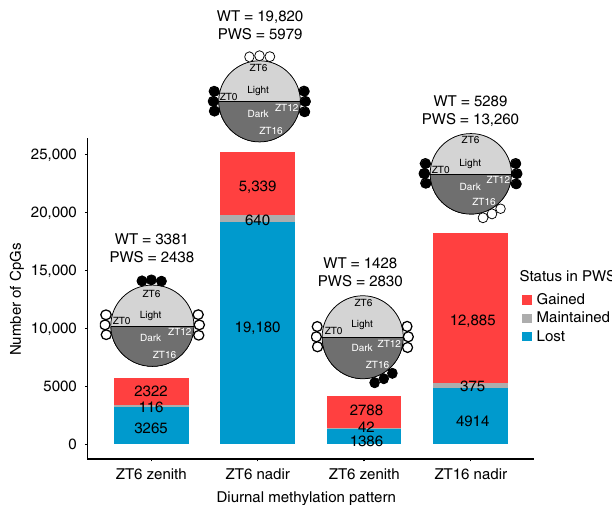
Fig. 3 The majority of rhythmic CpGs in WT cortex reach a nadir at ZT6, are lost in PWS, and are enriched in promoters and enhancers. Number of diurnally cycling CpGs disrupted in PWS. Diagrams above bars graphically represent how methylation nadirs and zeniths were de fi ned in WT, with open circles representing unmethylated and closed circles representing methylated CpG sites speci fi c to a time point. Total number of CpGs belonging to methylation class indicated above ZT0 vs. ZT6 ZT6 vs. ZT12 the two species (3,070 genes, p = 4.7 × 10 − 221 , OR = 2.7). We next utilized data from a recent study which evaluated the diurnal and seasonal rhythmicity of DNA methylation in Alzheimer ’ s disease (AD) and control human cortex to determine if genes with dysregulated methylation in human PWS exhibited diurnal rhythmicity 9 . To de fi ne a diurnally rhythmic gene set from this study, we empirically required 9% of CpGs assayed for each gene to demonstrate diurnal rhythmicity (Supplementary Fig. 4a). Despite differences in methylation analysis platform (WGBS vs. 450k array), 1,834 diurnally methylated human genes overlapped between studies, representing 21.3% of PWS-speci fi c DMR − 96 , OR = 2.1, Fig. 1c and Supple- identi fi ed genes ( p = 1 × 10 mentary Data 3). When PWS DMR genes are fi ltered for rhythmicity, the signi fi cant overlap between mouse and human is maintained, suggesting that rhythmically methylated genes play an essential and conserved role in PWS (250 genes, p = 3.3 × 10 − 13 , OR = 1.7, Supplementary Fig. 4b). These genes Fig. 2 DNA methylation is diurnally rhythmic during light hours in WT, but altered to predominantly dark hours in PWS mouse cortex. a Principal component analysis of WT vs PWS DMRs. Genotype-speci fi c DMRs separate on the basis of time in WT cortex during light hours, but not in PWS cortex. Ellipses represent the 95% con fi dence interval for each group. Non-overlapping ellipses indicate a signi fi cant difference in methylation pro fi le ( p < 0.05). b Rhythmic CpGs during light and dark hours in WT and PWS cortex. Venn diagram overlaps represent the number of rhythmic CpGs. Top = light hours (ZT0 – ZT12), Bottom = dark hours (ZT12 – ZT0). 23,201 WT light rhythmic CpGs > 8,417 Snord116 + / − light rhythmic CpGs (Fisher ’ s exact test, p < 0.0001) and 16,090 Snord116 + / − dark rhythmic CpGs > 6,687 WT dark rhythmic CpGs (Fisher ’ s exact test, p < 0.0001) groups (2,362 genes, p < 0.0001, OR = 5.3). In order to assess the relevance of our mouse study to human PWS, we utilized previously published WGBS data to identify human cortex PWS DMRs (Fig. 1c, Supplementary Data 3) 42 . 52.8% of the genes associated with PWS DMRs in mouse overlapped with human PWS-speci fi c DMRs, representing a signi fi cant overlap between